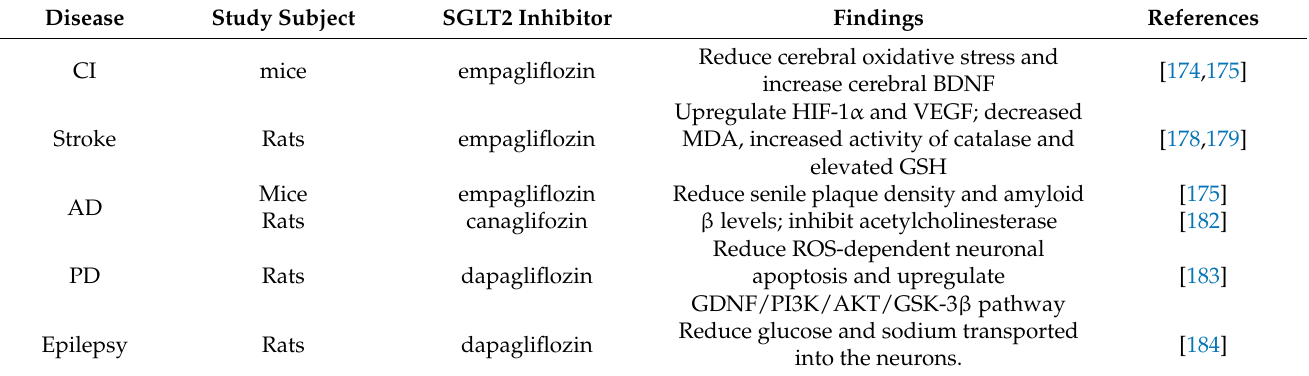
Table 3. Preclinical evidence for the therapeutic implications of SGLT2 inhibitors in neural